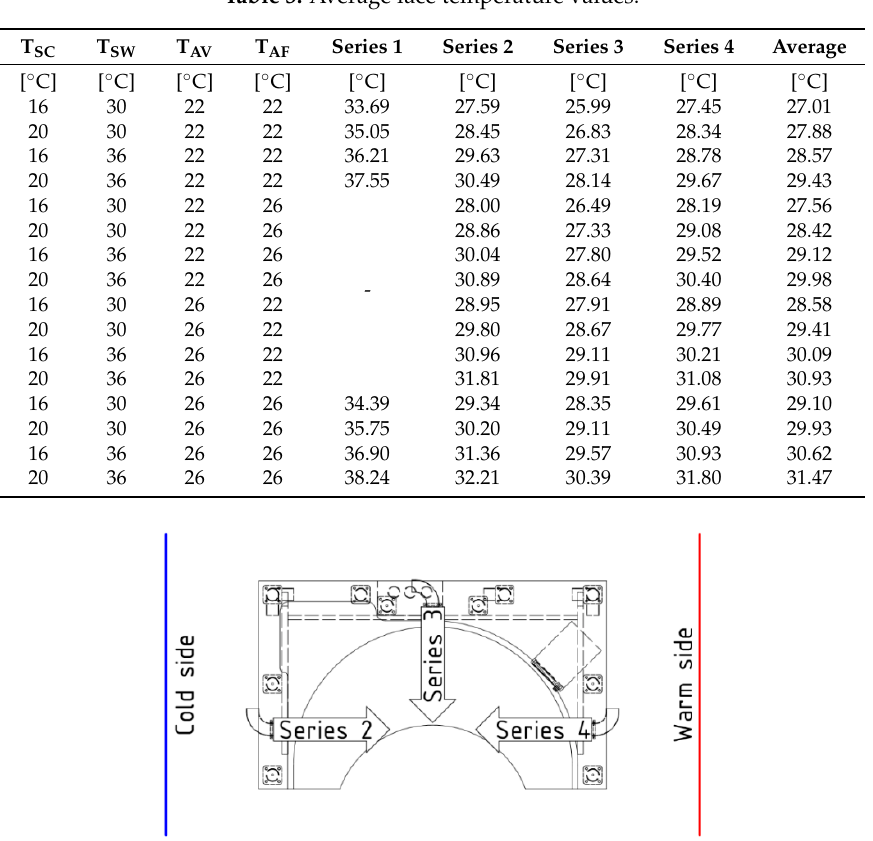
Table 3. Average face temperature values.